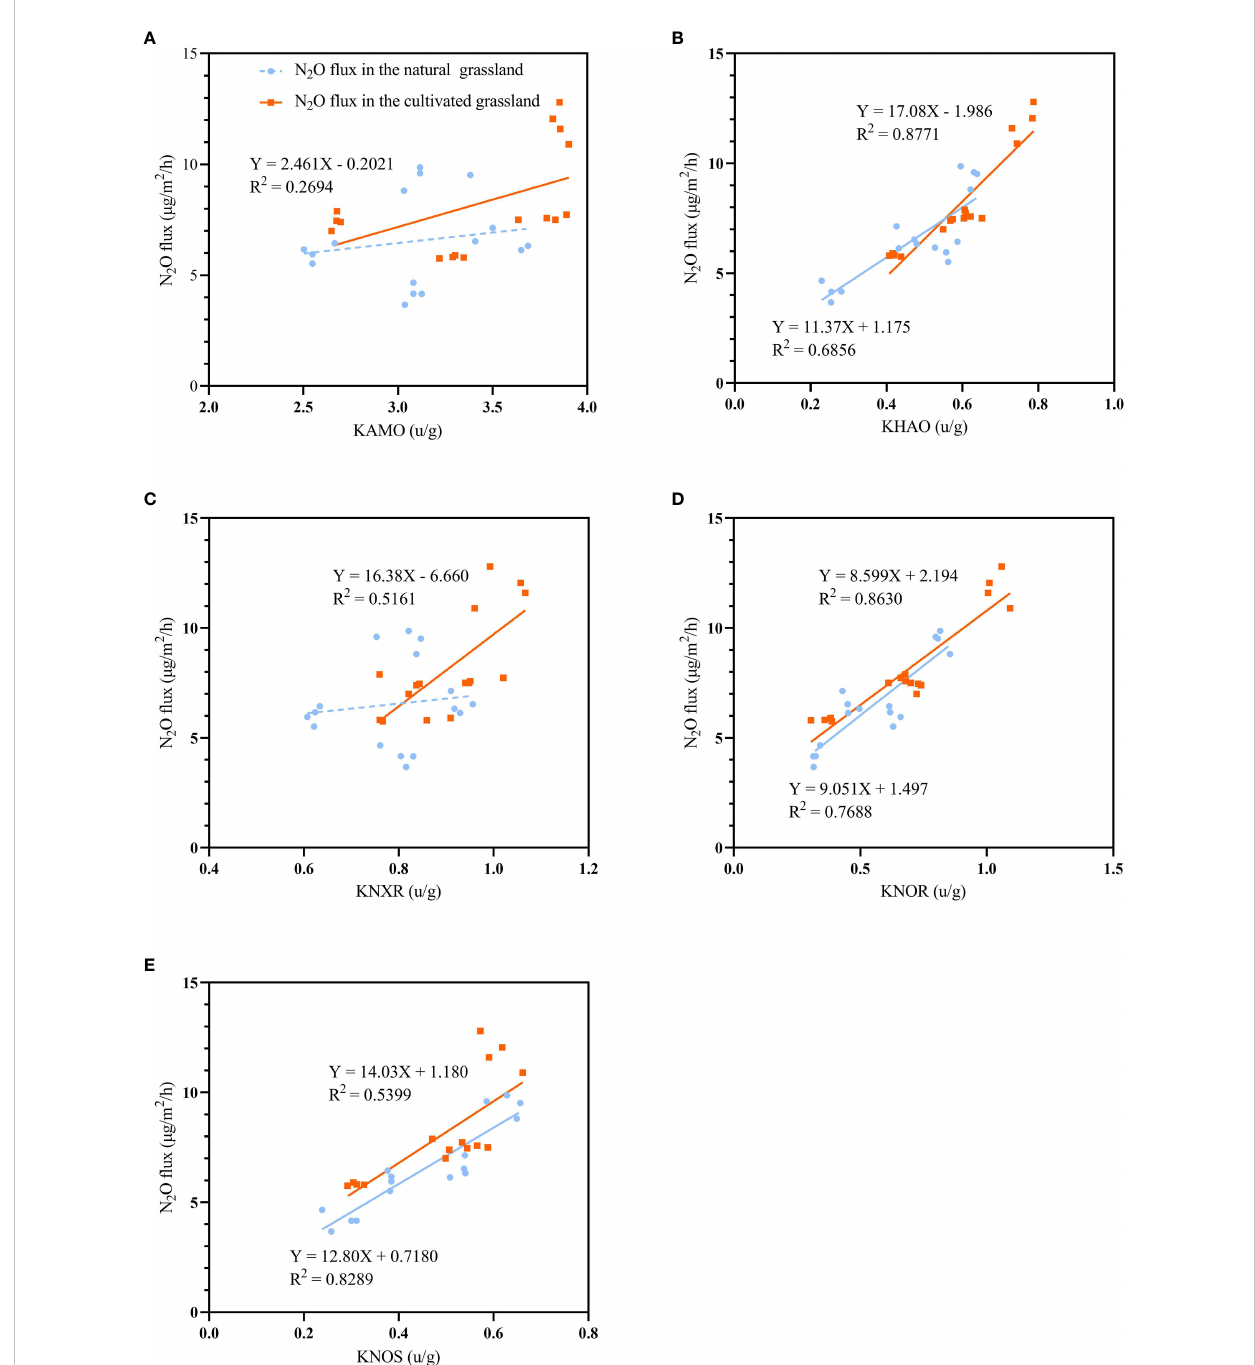
FIGURE 5 Linear regression between N 2 O emission fl ux and enzymatic activity of AMO (A) , HAO (B) , NXR (C) , NOR (D) and NOS (E) (KAMO, KHAO, KNXR, KNOR, KNOS) in natural alpine meadow (blue dot and line) and cultivated grassland (orange square and line). Solid line indicates p < 0.05 and dotted line indicates p >